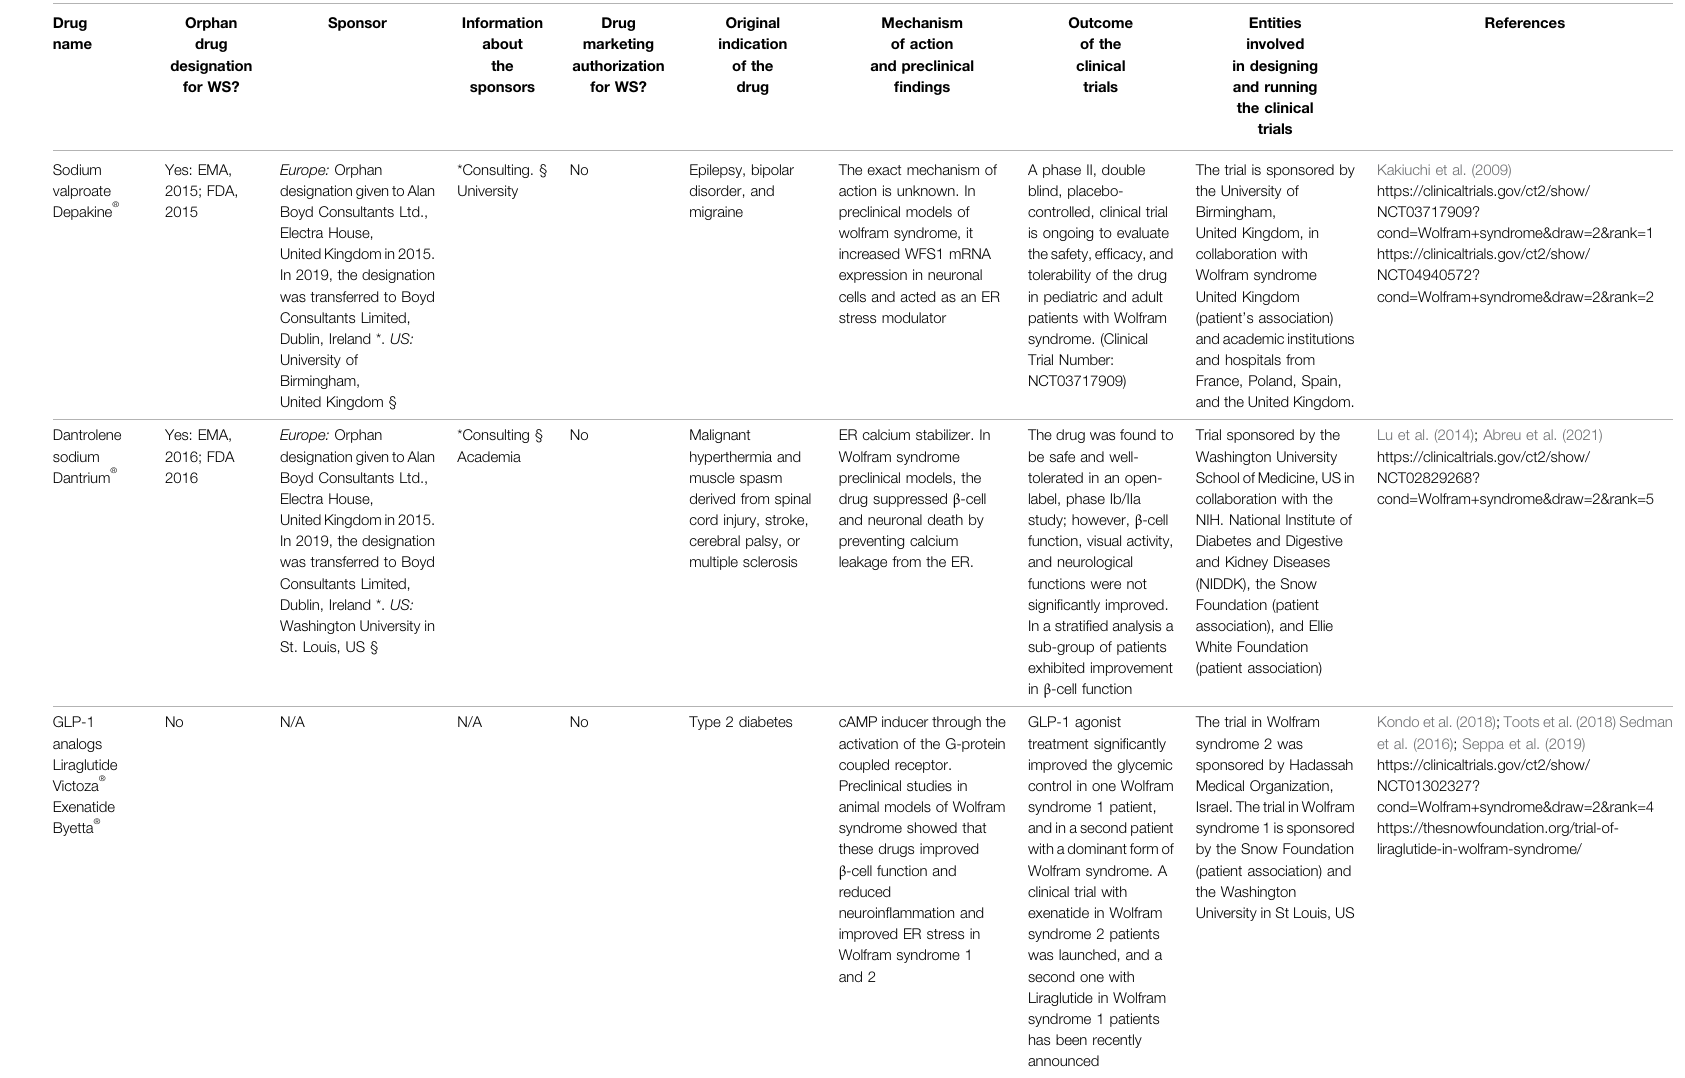
The following websites were consulted to build up this table. Community Register of orphan medicinal products from the European commission: https://ec.europa.eu/health/documents/community-register/html/reg_od_act.htm?sort (cid:1) a; Orphan Drug Designations and Approvals from the FDA: https://www.accessdata.fda.gov/scripts/opdlisting/oopd/. ClinicalTrial.gov to retrieve the list of clinical trials for WS: https://clinicaltrials.gov/ct2/results?cond (cid:1)